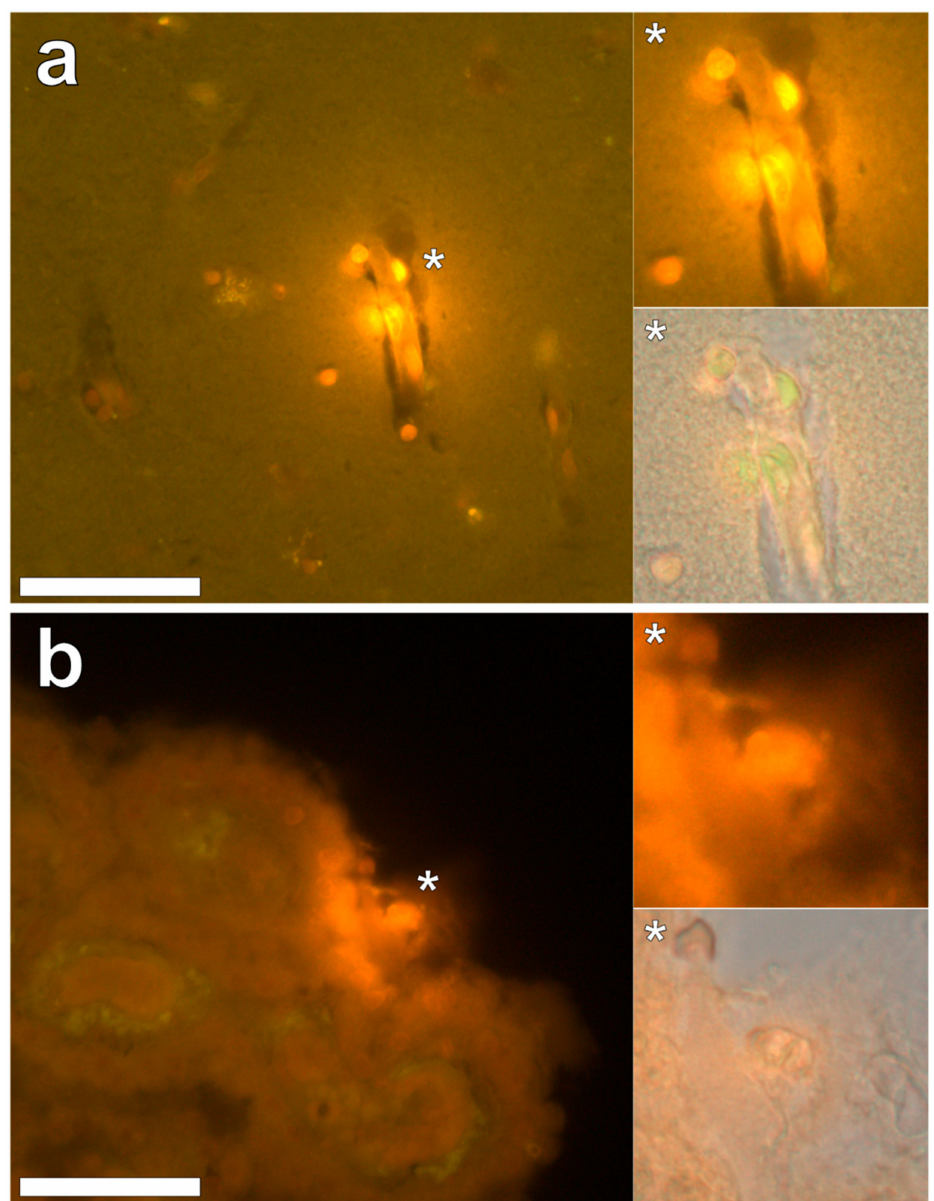
Figure 8. Intracellular lumogallion-reactive aluminium localised within the hippocampus. Intracellular bright orange fluorescence was noted in inflammatory cells in the vessel wall ( a ) and within ependymal cells lining the choroid plexus ( b ). Magnified inserts are denoted by asterisks with lower panels including a bright field overlay. Magnification 400 × ; scale bars 50 µ